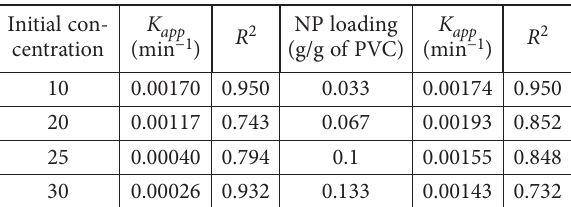
Table 3. First order (apparent) rate constants for photocatalytic degradation of Methylene